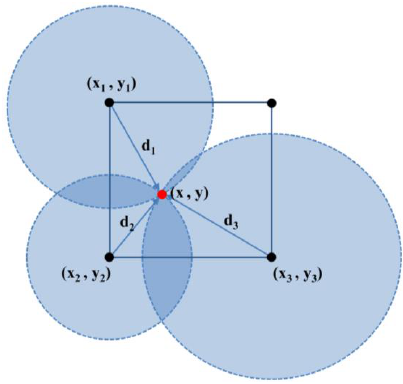
Figure 3. Determination of location using triangular survey in RTL system.